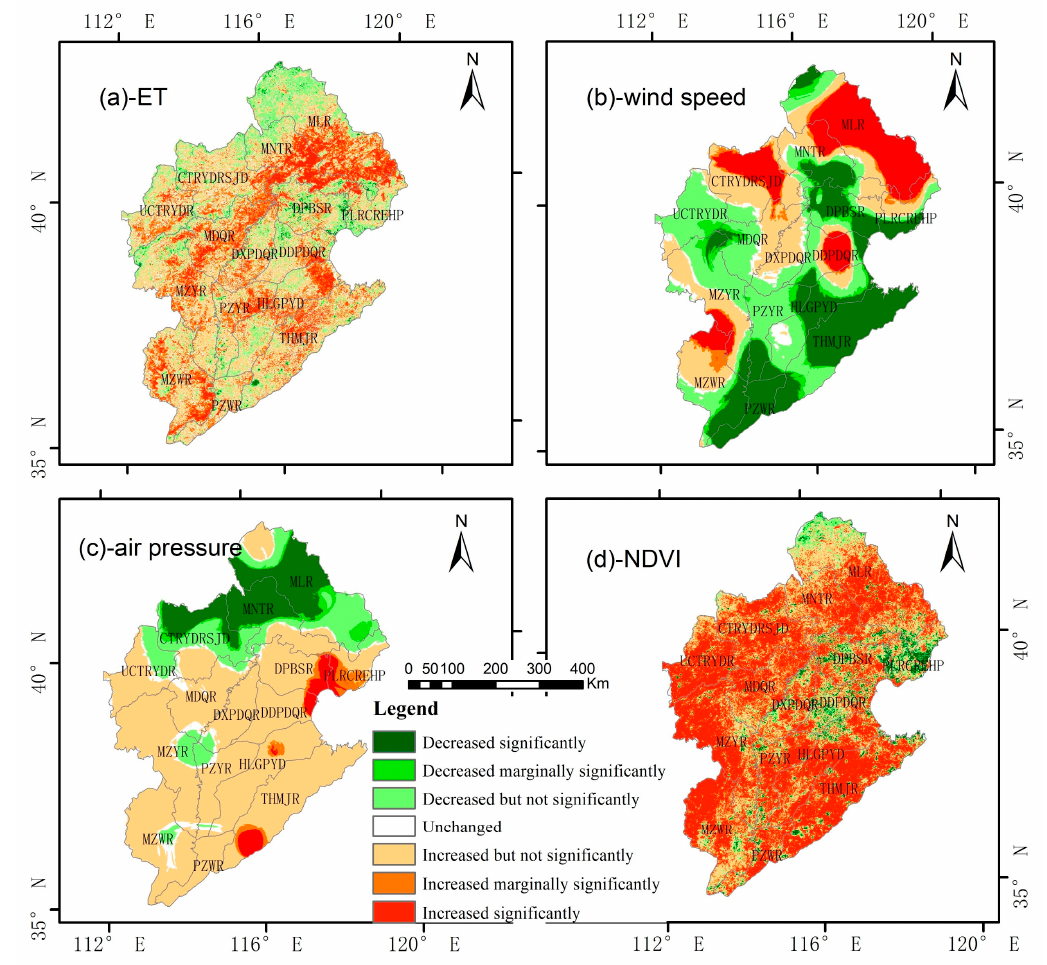
Figure 6. The temporal trends of ET ( a ); wind speed ( b ); air pressure ( c ) and NDVI ( d ) in the Hai Basin during 2000 to 2014. Mann-Kendall test was used in each pixel to determine the trend. Based on the sign of Z, the trends was divided into three: increase: Z > 0, unchanged Z = 0, decrease Z < 0; The confidence were classified into three levels according to absolute value | Z | and Z α /2 : significant ( | Z | > Z α /2 = 1.96, α = 0.05), marginally significant (1.96 > | Z | > Z α /2 = 1.64, α = 0.1) and not significant (0 < | Z | < Z α /2 = 1.64, α =